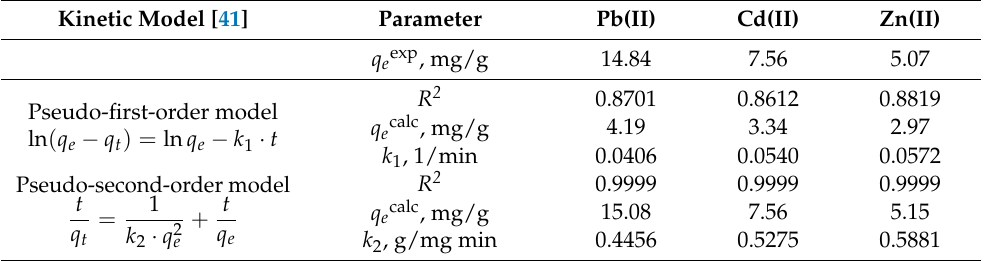
Table 4. Kinetic parameters obtained for the biosorption of Pb(II), Cd(II), and Zn(II) on Na-SW biosorbent.